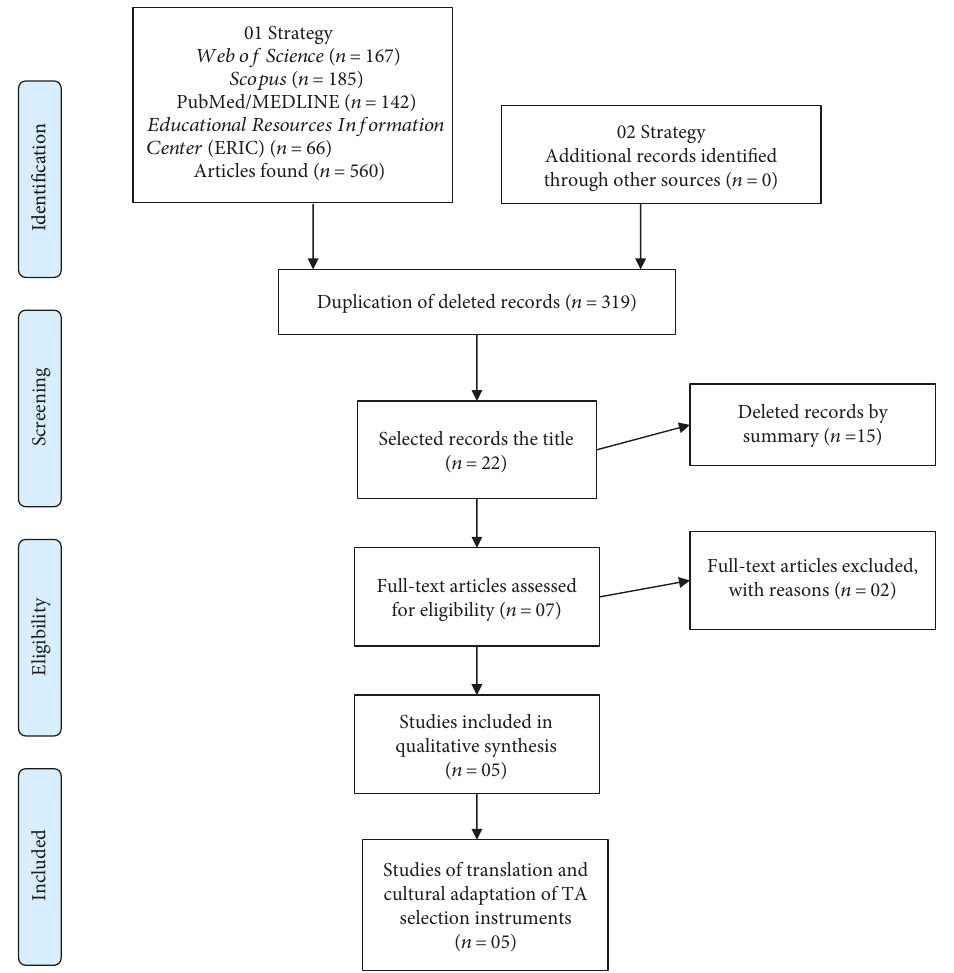
Figure 2: PRISMA 2009 Flow Diagram — selection process for the studies included in the